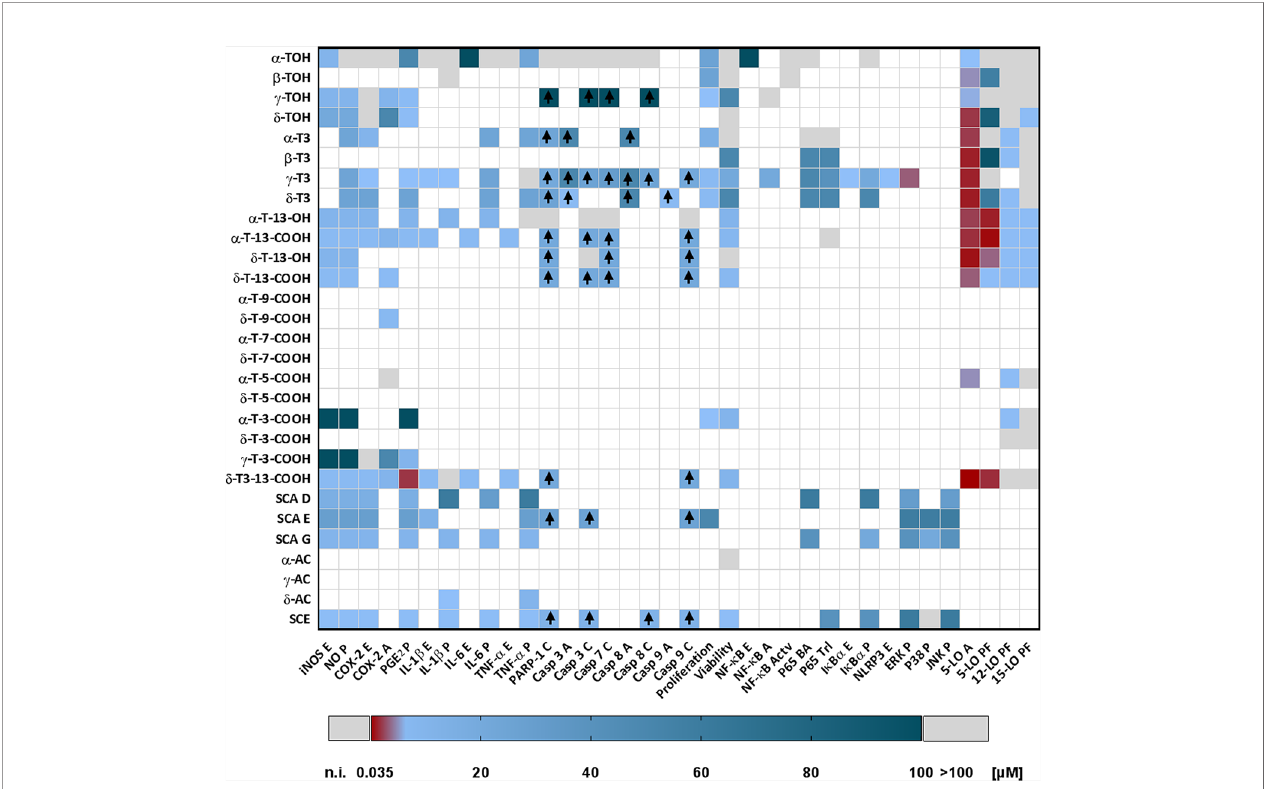
FIGURE 8 | Heatmap illustrating the effectiveness of chromanol and chromenol structures on selected targets. If not indicated otherwise, the plotted effects represent inhibitory effects of the respective compound on distinct parameters; induced parameters are marked with an arrow ( ↑ ). The color coding of the presented heat map ranges from high-af fi nity targets and parameters (effect with <1 µM) presented in red to low-af fi nity targets and parameters (effects with >1 µM to ≤ 100 µM) presented in dark blue. If a compound did not affect a speci fi c factor/parameter or showed low effectiveness (>100 µM), the factor/parameter is marked in light gray. Factors and parameters lacking data are marked in white. The heat map is considered as simpli fi ed guide for orientation and does not provide a detailed summary of the topic. All concentrations are given micromole (µM). Abbreviations used are: Actv, activation; A, activity; BA, binding af fi nity; C, cleavage; E, expression; PF, product formation; P, production; T,